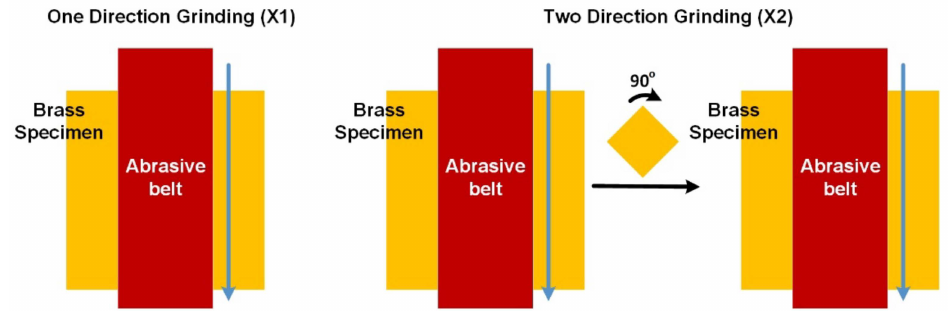
Figure 1. Two kinds of grinding processes utilized in this work: one-direction grinding and two- orthogonal-direction